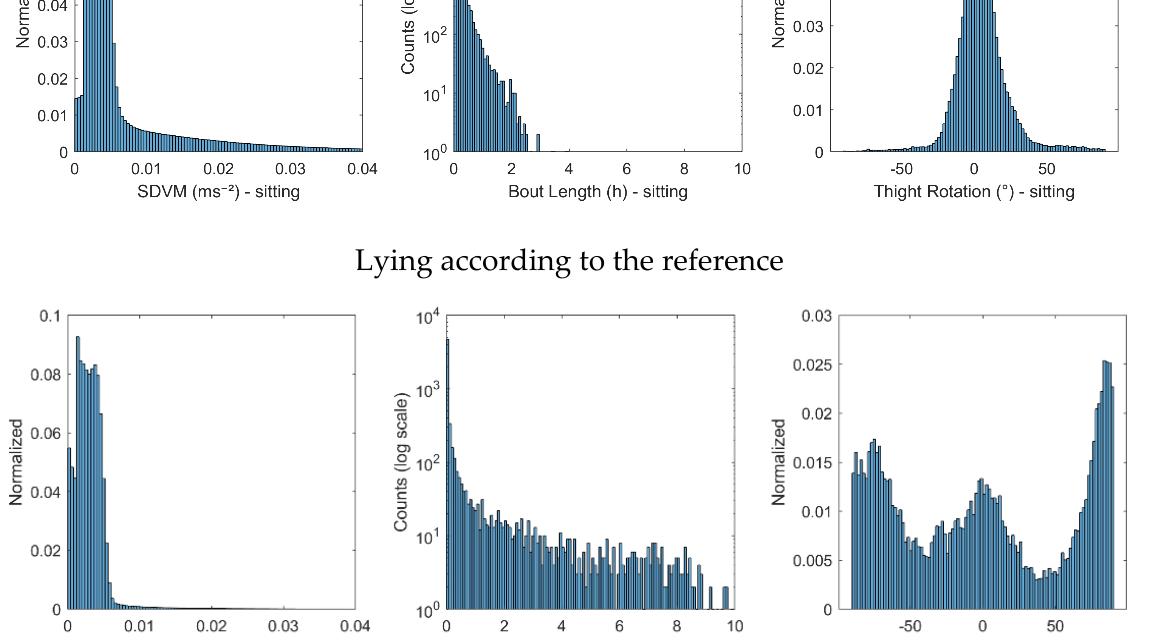
Figure 2. The distributions of parameters SDVM, time duration of sedentary bouts (bout lengths) and thigh rotation angle, during sitting and lying down, according to the reference method in the development dataset.